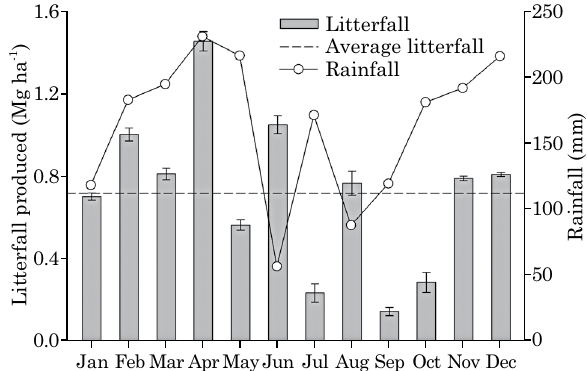
figure 2. monthly litter deposition and rainfall in 16-year-old Pinus taeda stands, in otacílio costa, Sc, brazil, January 2011 until december